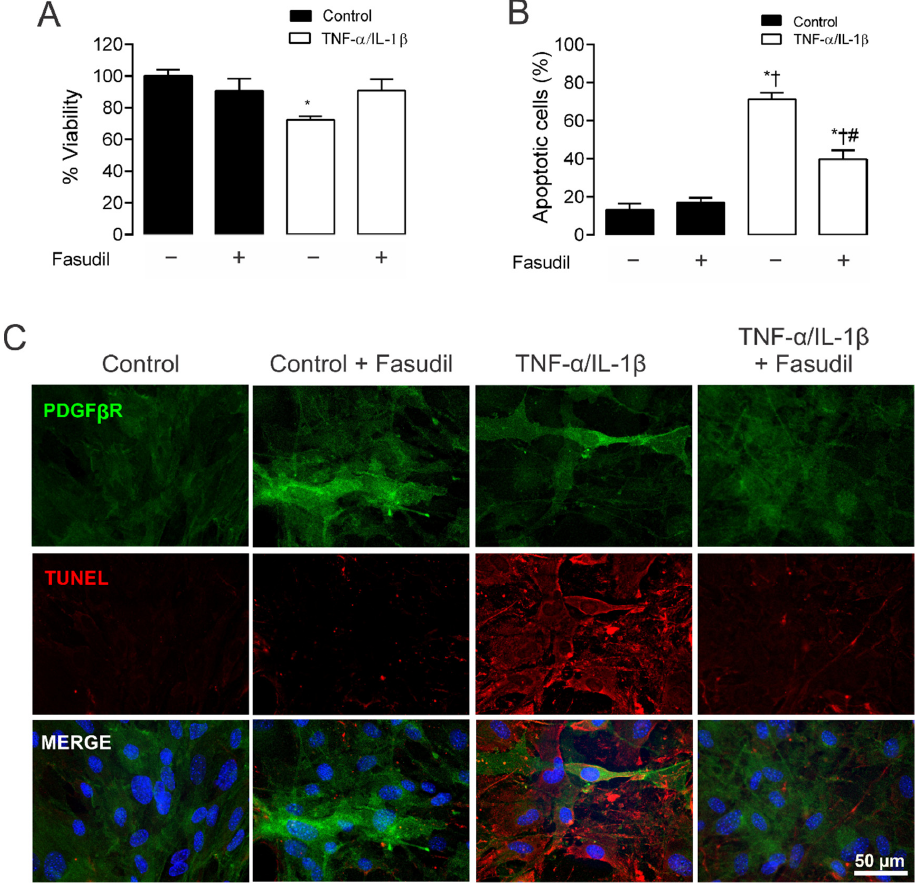
Figure 6. Blockade of ROCK prevents apoptosis, preserving cell viability in primary mesangial cells stimulated with TNF- α /IL-1 β . Graphs showing the measurement of ( A ) cell viability and ( B ) % apoptotic cells in MCs under control conditions (black bars) or exposed to TNF- α /IL-1 β (white bars) for 72 h. ( C ) Fluorescence images depicting PDGF β R (green), Tunel (red) and DAPI (blue) staining by primary MCs stimulated for 72 h with 10 ng/mL TNF- α /IL-1 β . Calibration bar: white = 50 µm. Fasudil (15 µ M) was added 24 h before harvesting the cells. Each bar represents the mean value ± SEM of 3 independent experiments. Statistical significance * p < 0.05 vs. Ctrl; † p < 0.05 vs. Ctrl + Fasudil # p < 0.05 vs. TNF- α /IL-1 β